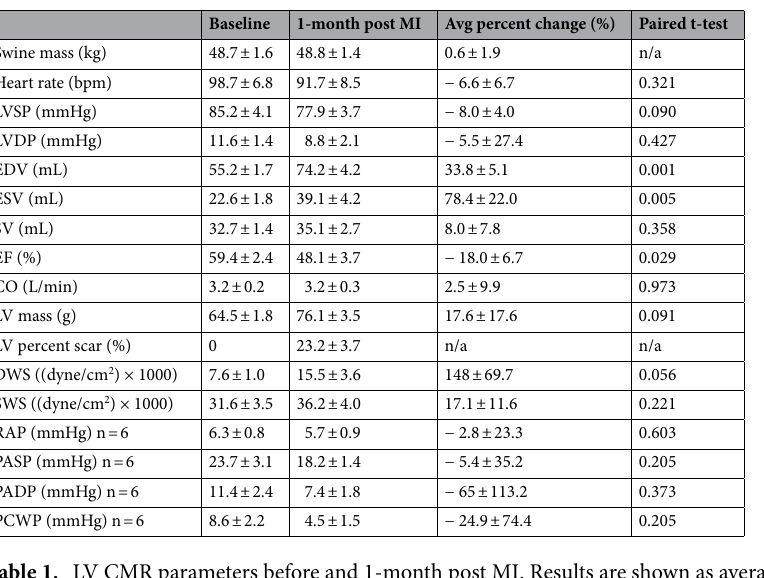
Table 1. LV CMR parameters before and 1-month post MI. Results are shown as average ± SEM (n = 9, unless otherwise noted in table). Paired percent changes were calculated then averaged. EDV end diastolic volume, ESV end systolic volume, LVSP left ventricular systolic pressure, LVDP left ventricular systolic pressure, SV stroke volume, EF ejection fraction, CO cardiac output, LV left ventricle, DWS diastolic wall stress, SWS systolic wall stress, RAP right atrial pressure, PASP pulmonary artery systolic pressure, PADP pulmonary artery diastolic pressure, PCWP pulmonary capillary wedge pressure.